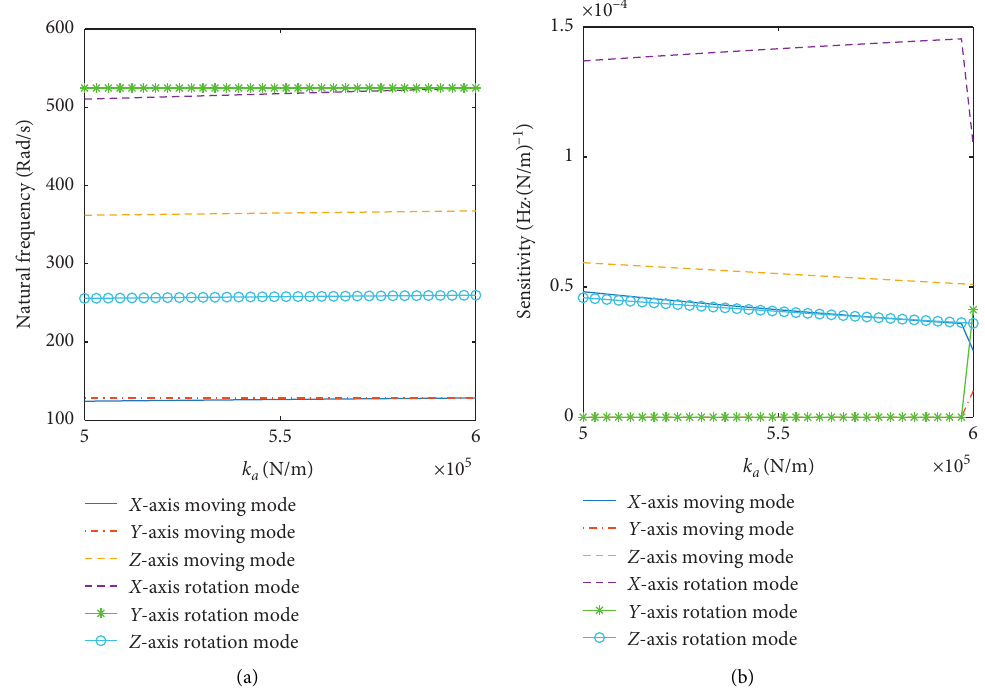
Figure 5: Curve of natural frequency and its sensitivity changing with the stiffness of outer leg 1. (a) Natural frequency. (b) Sensitivity of natural frequency to the stiffness of outer leg 1.